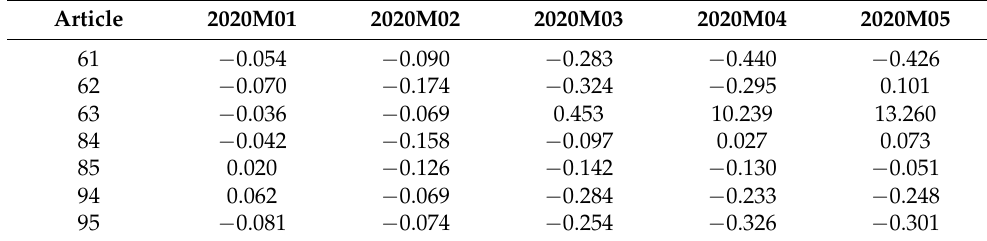
Table 2. Growth of imports year over year by month.